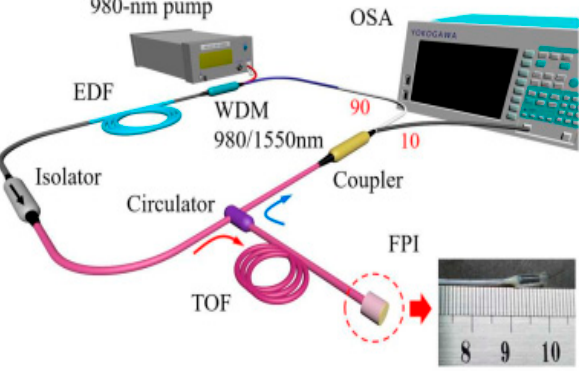
Figure 10. Experimental set up of humidity sensor.